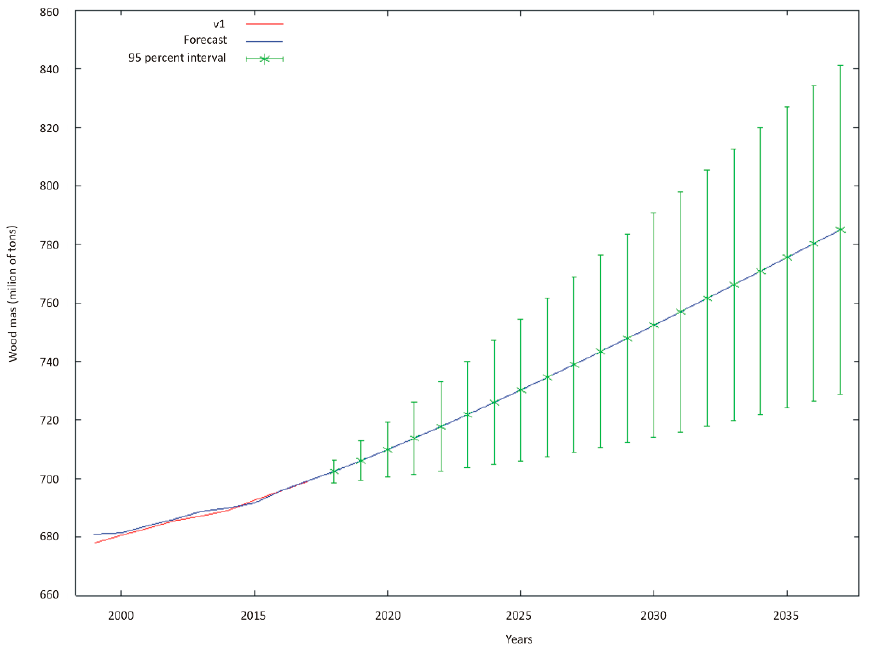
Figure 6. Prediction of total wood biomass to 2040.